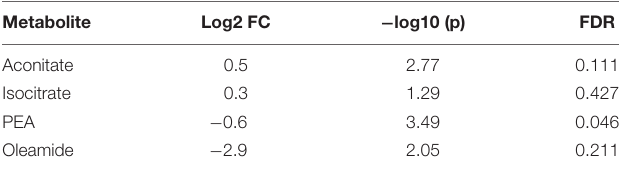
TABLE 2 | Levels of metabolites identified as potential biomarkers of the premutation. Metabolite Log2 FC − log10 (p) FDR Aconitate 0.5 2.77 0.111 Isocitrate 0.3 1.29 0.427 PEA − 0.6 3.49 0.046 Oleamide − 2.9